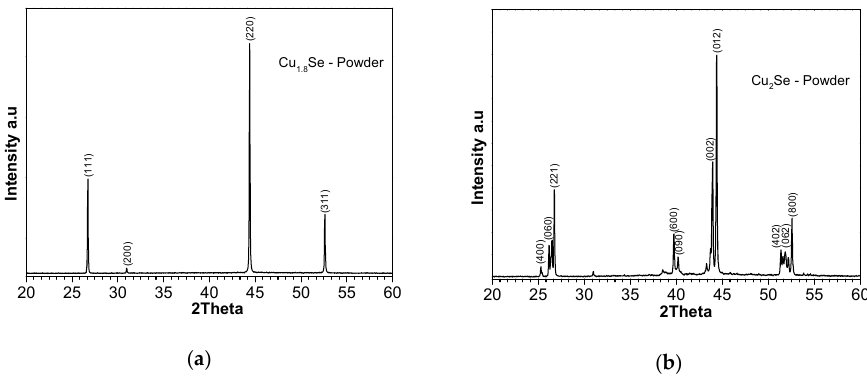
Figure 2. The room-temperature X-ray powder di ff raction (XRPD) patterns of as-prepared powder and SPS sintered samples of ( a ) Cu 1.8 Se and ( b ) Cu 2 Se. Indexing was performed against Cu 2 Se phase with International Centre for Diffraction Data-ICDD card No. 27-1131, and Cu 1.8 Se phase with ICDD card No. 01-071-0044.